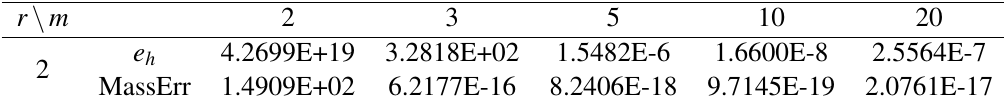
Table 4 The effect of m on the